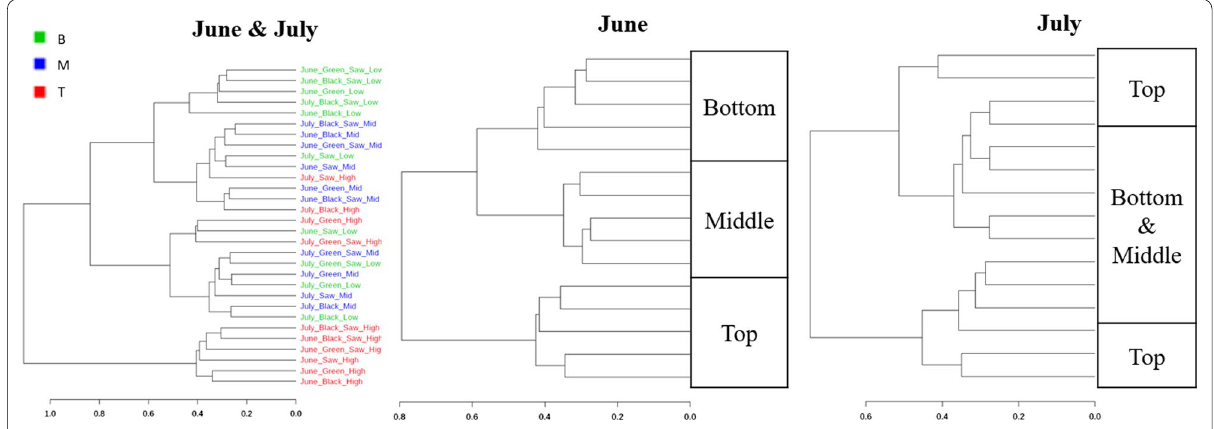
Fig. 5 Dendrogram of soil microbiome in five different mulch types, depths, and months. B Bottom, M Middle, T